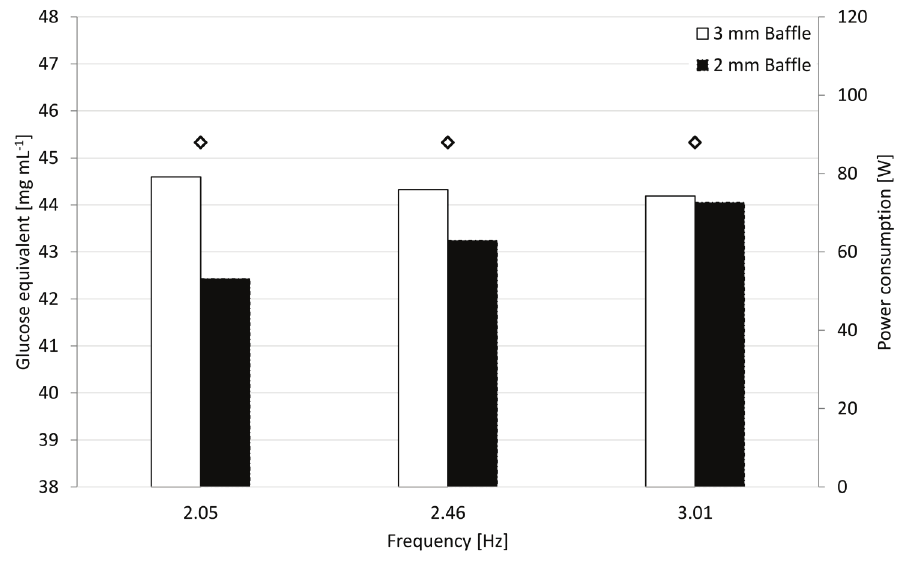
Fig. 6 – Influence of different baffle thicknesses and frequencies on power consumption and glucose concentration (15 % SL, α-cellulose, 10 mm amplitude, 10 FPU, 50